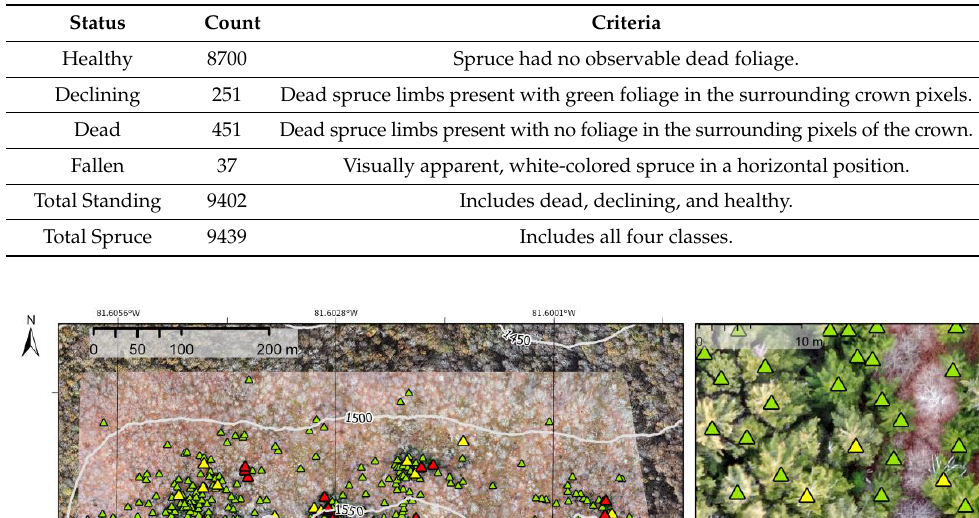
Table 2. Numbers and percentages of red spruce trees in each health category.